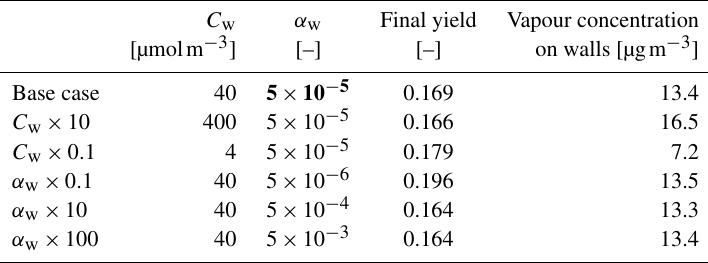
Table 3. Sensitivity of the vapour wall losses to parameters C w and α w